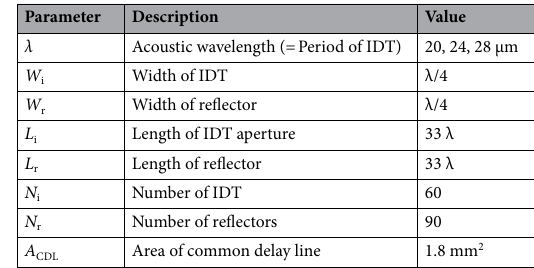
Table 1. Design parameters of the multi-frequency SAW